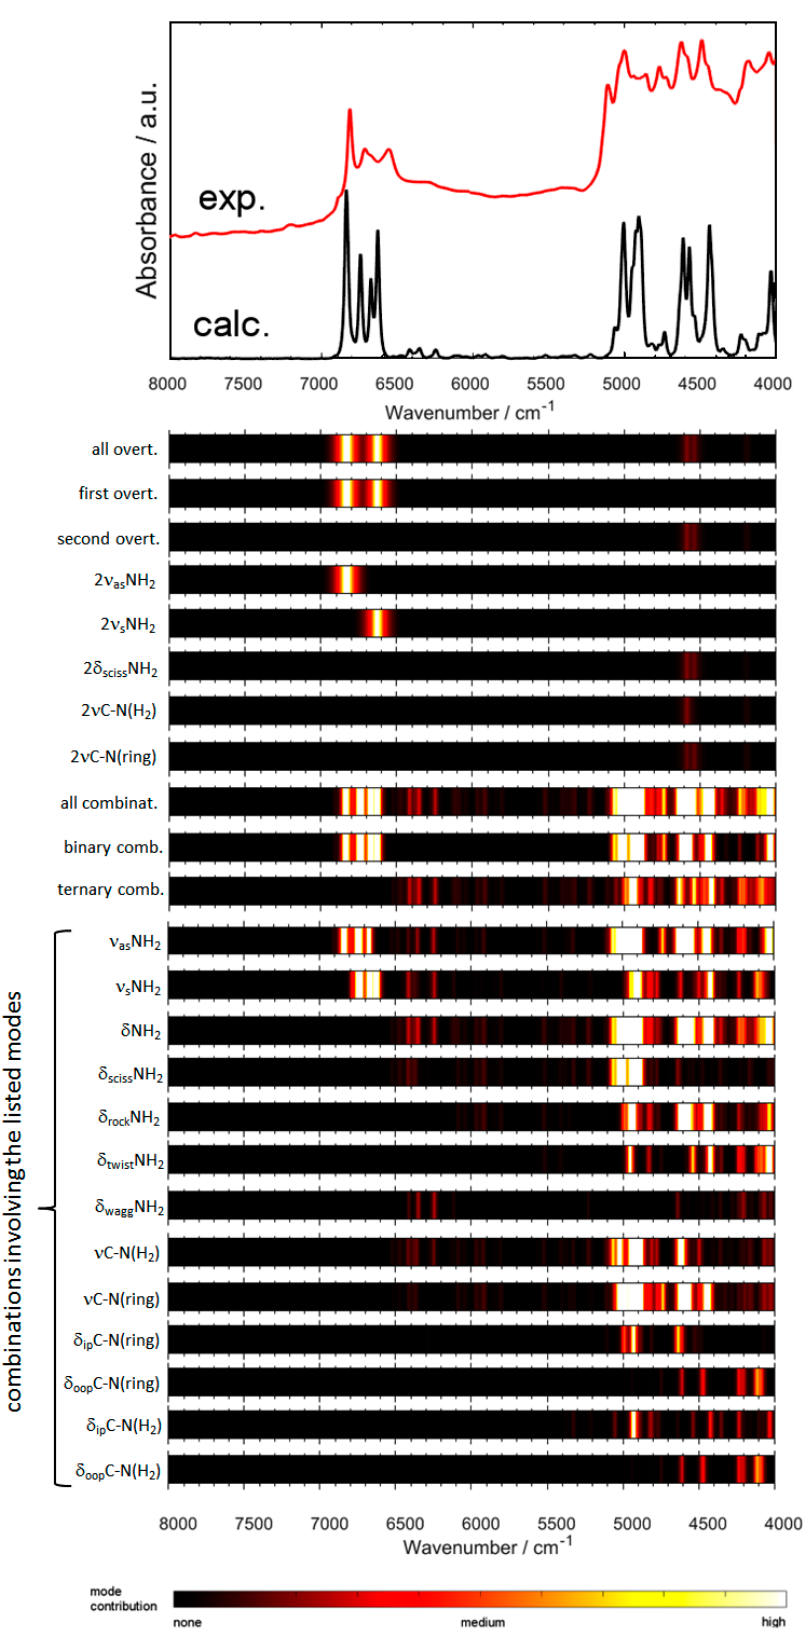
Figure 5. Analysis of the contributions to NIR spectrum of polycrystalline melamine based on the calculated spectrum (GVPT2//B3LYP-GD3BJ/SNST).